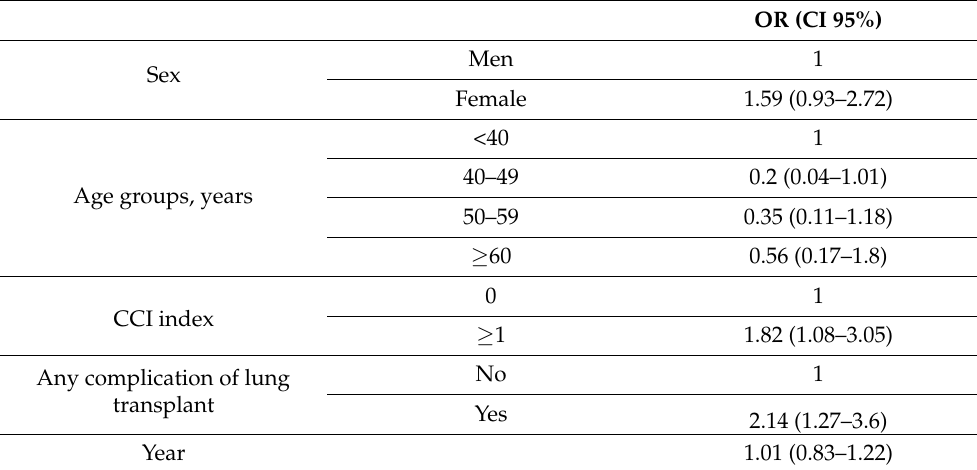
Table 5. Multivariable analysis of the factors associated with in hospital mortality among COPD patients after a lung transplantation in Spain,